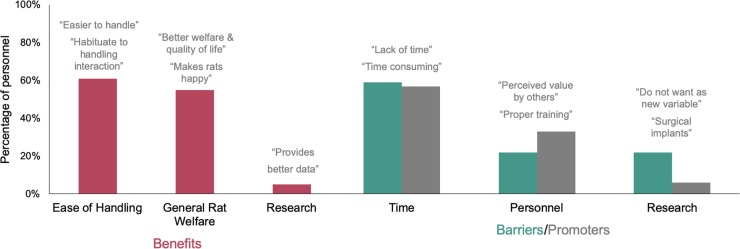
Benefits & control beliefs about rat tickling.The most common themes relating to benefits (advantages) and control beliefs (factors that are barriers that make it difficult or promoters that would make it easier) about rat tickling by 611 laboratory animal personnel currently working with rats. Graphic includes representative quotes. Sub themes and additional representative quotes are presented in S3 and S4 Tables.